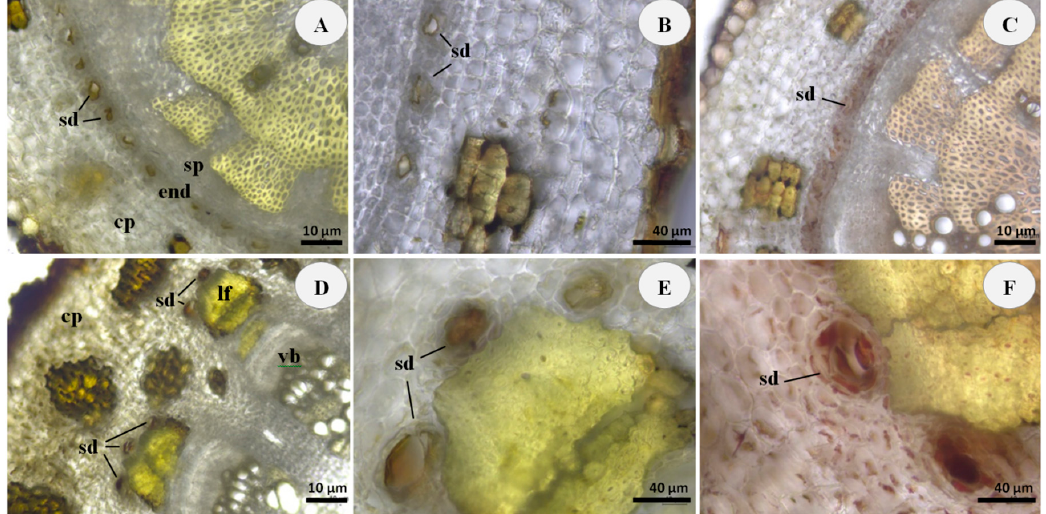
Figure 2. Root and rhizome transverse sections of cultivated R. carthamoides : ( A ) General aspect of unstained root section, showing the presence of secretory ducts (sd) arranged in a ring along the endoderm (end) between the cortical parenchyma (cp) and secondary phloem (sp); ( B ) Details of root secretory ducts (sd), containing orange-brown secretion; ( C ) Secretory ducts (sd) of root stained orange-red with Sudan III for the presence of lipophilic substances; ( D ) Unstained rhizome section, showing the presence of secretory ducts (sd) located on the group of lignified fibers (lf) capping the vascular bundles (vb); ( E ) Details of rhizome secretory ducts (sd) filled with orange-brown secretion; ( F ) Secretory ducts (sd) of rhizome stained orange-red with Sudan III for the presence of lipophilic substances; Scale bars: A, C, D = 10 μ m; B, E, F = 40 μ m.